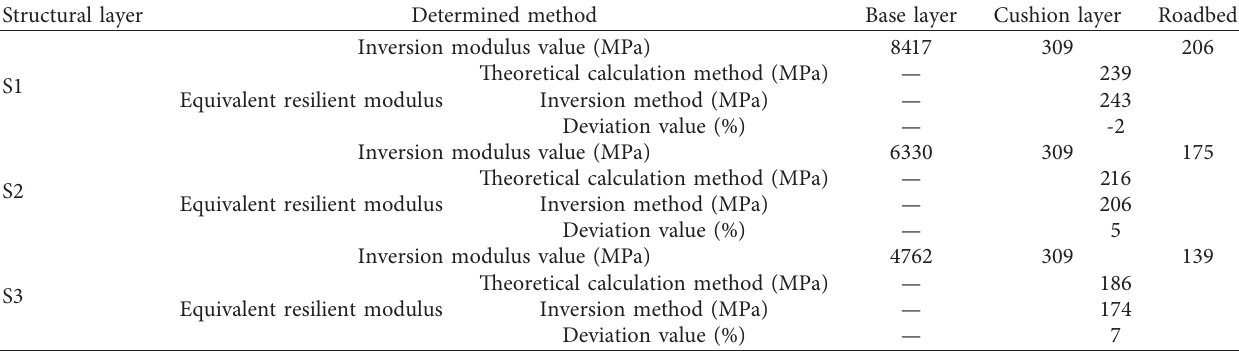
Table 3: The calculation of equivalent resilient modulus of the top surface of the cushion layer when FWD is loaded on the top surface of the base layer.